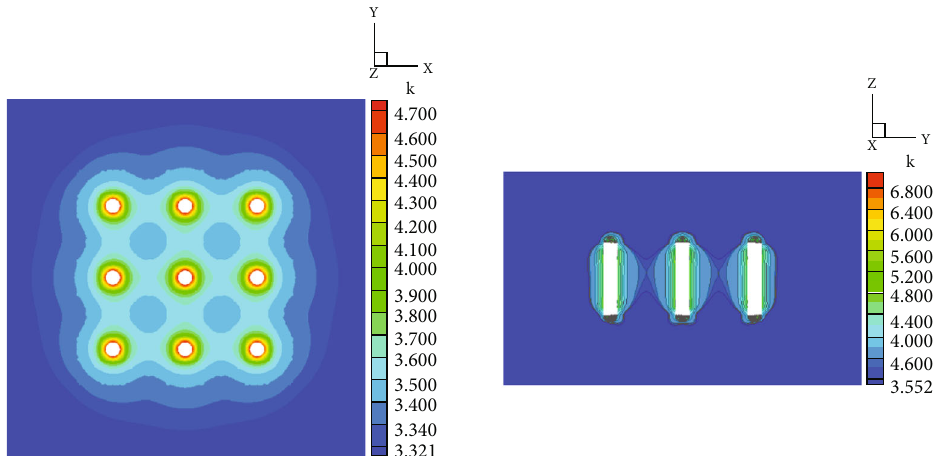
Figure 7: Permeability changes in horizontal and vertical pro fi les after hydraulic perforation.